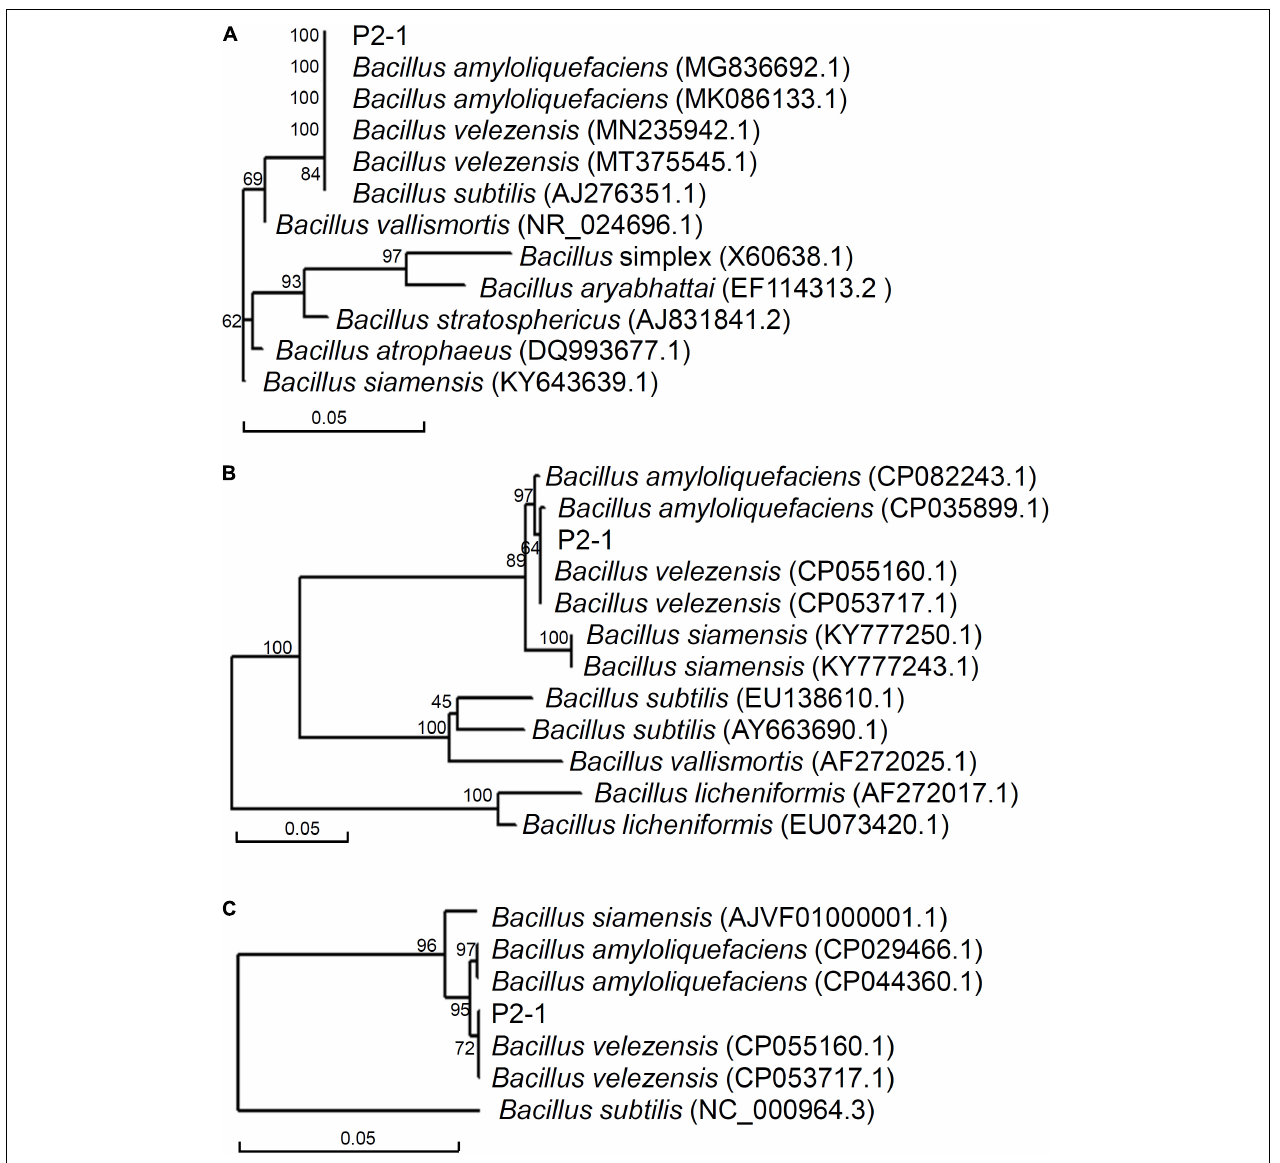
FIGURE 2 | Phylogenetic analysis of strain P2-1 and its relatives based on 16 S rDNA (A) , gyrA (B) , and ropB (C)